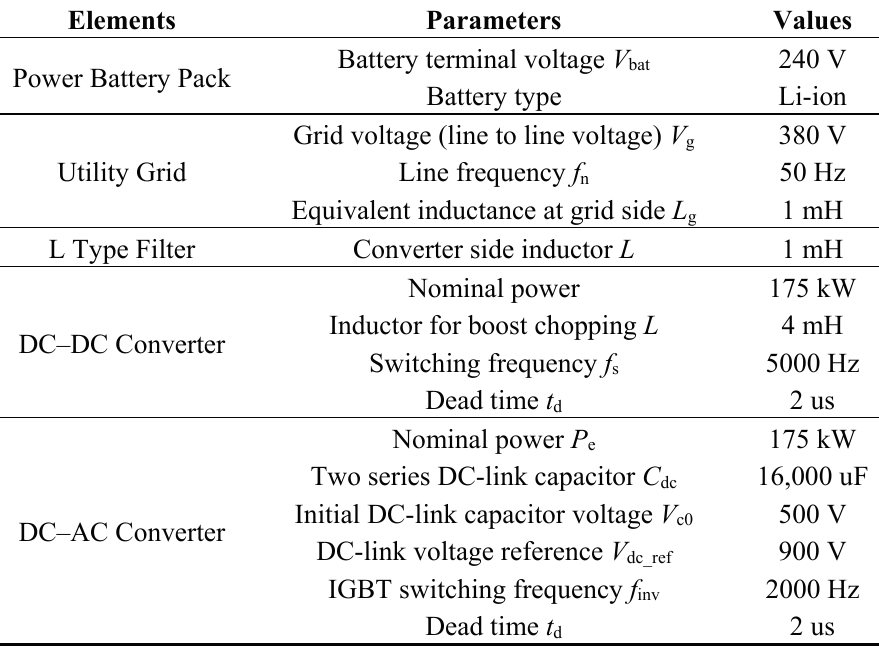
Table A2. Specifications of the proposed